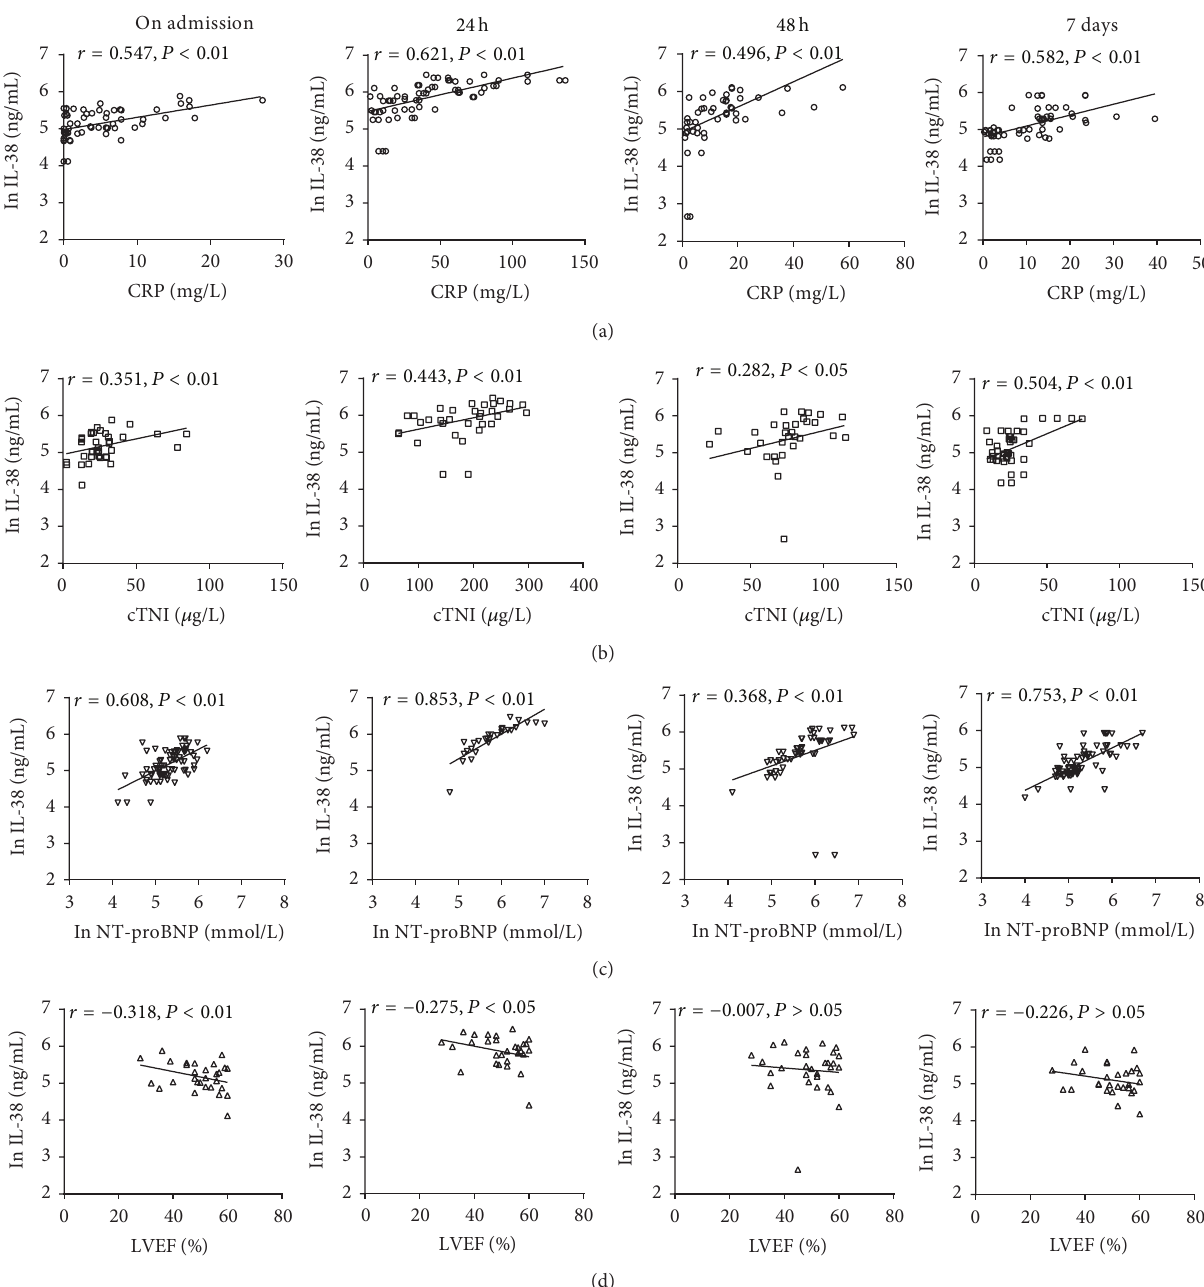
Figure 4: Spearman’s correlation between IL-38 and CRP, cTNI, NT-proBNP, and LVEF in patients with STEMI. (a)–(c) IL-38 levels were positively correlated with CRP, cTNI, and NT-proBNP in STEMI patients at each time-point. (d) IL-38 concentrations were weakly negatively correlated with LVEF in STEMI patients at each time-point. Data are presented as mean ±